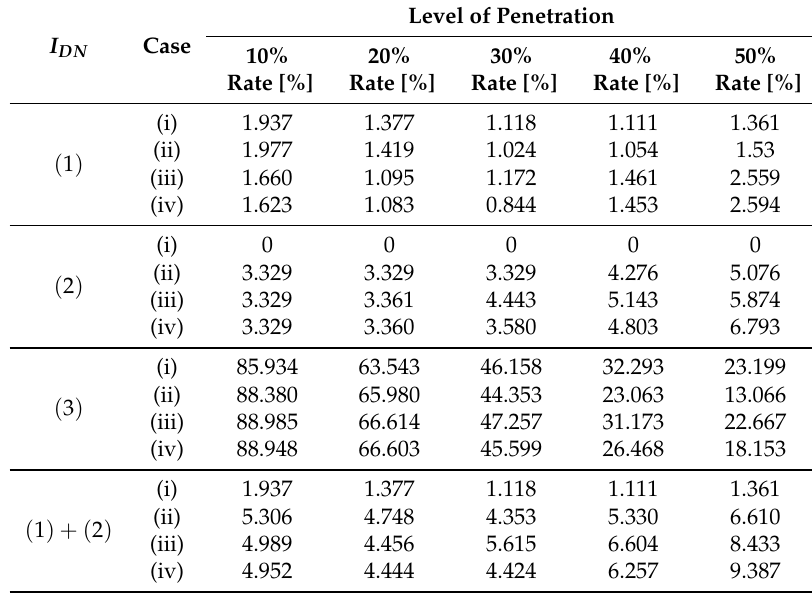
Table 21. Summary of DN indicators.